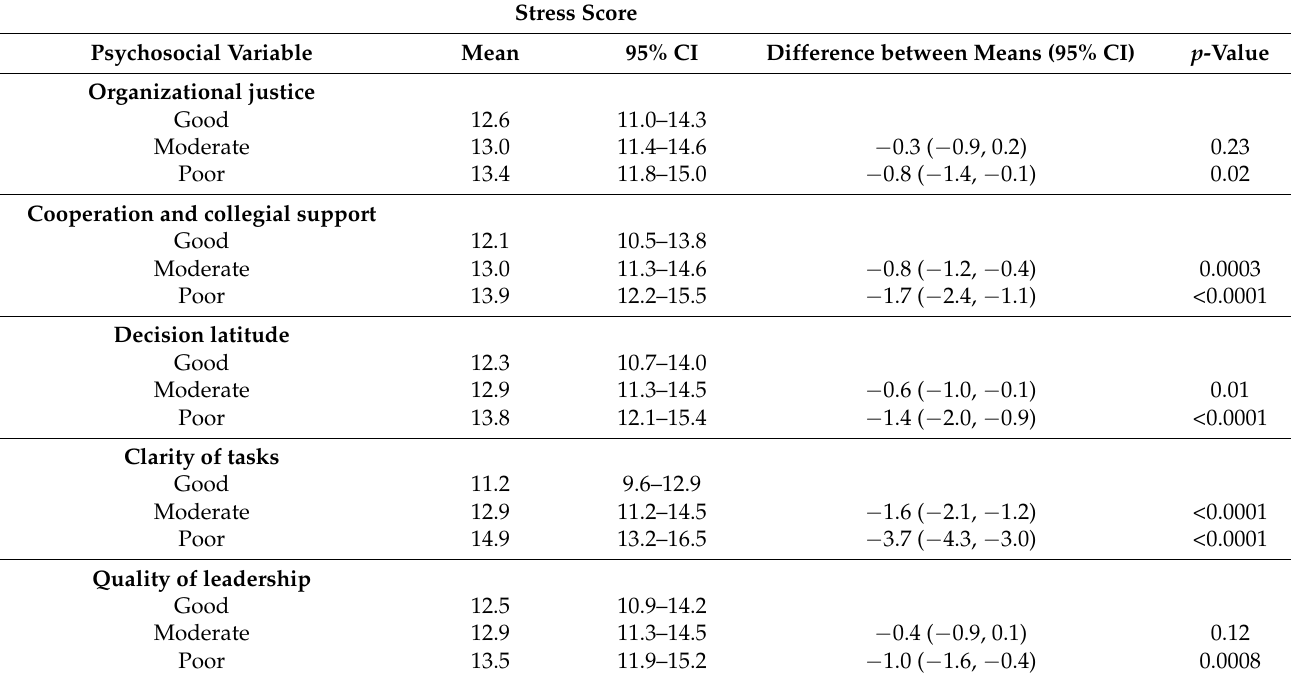
Table 3. Model 2. Mutually adjusted psychosocial variables and stress scores (0–40). Stress